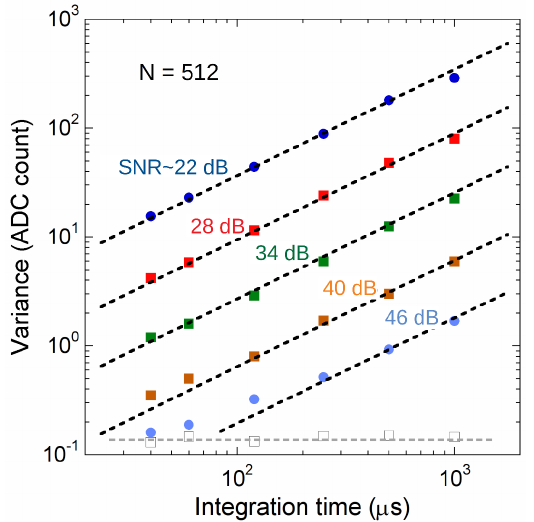
Figure 12. Variance values as a function of the integration time period obtained for di ff erent white current noise amplitudes. A minimum constant value is observed (open squares) and related to the intrinsic system